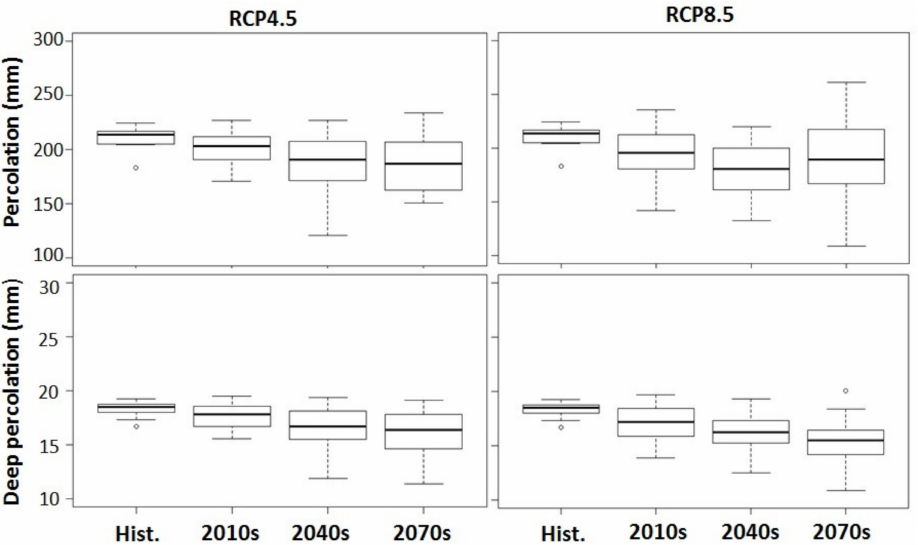
Figure 9. Percentage (%) change of percolation, and deep percolation during the cropping period (June-September) in the Jeonju metrological station area for the 2010s (2nd column), 2040s (3rd column), 2070s (4rd column) considering RCP4.5 ( left side ) and (2) RCP 8.5 ( right side ) scenarios relative to the historical period (1st column) considered as baseline